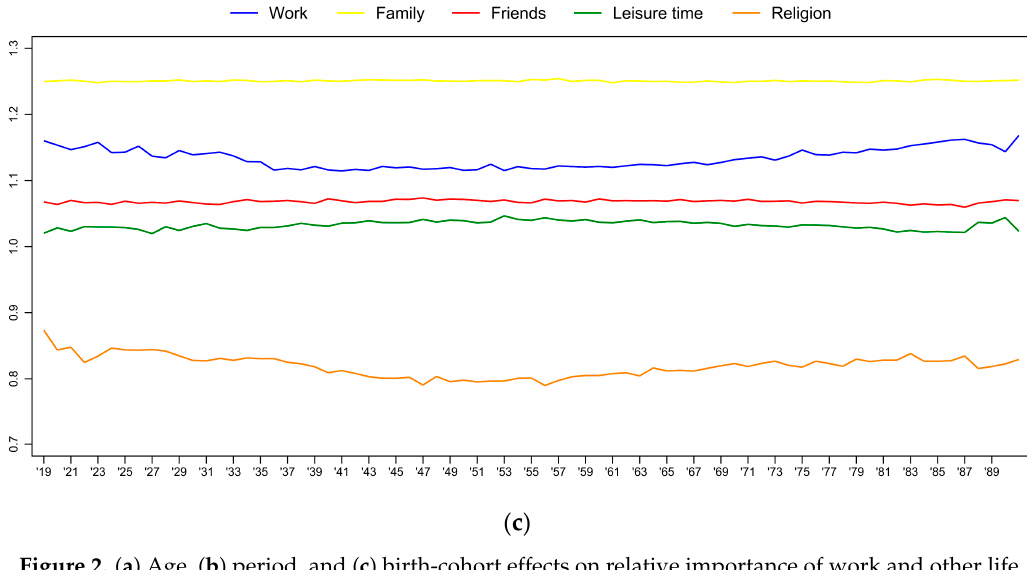
Figure 2. ( a ) Age, ( b ) period, and ( c ) birth-cohort effects on relative importance of work and other life aspects (hierarchical age-period-cohort regression models). The y -axis shows the predicted value of the dependent variable (for an average respondent).